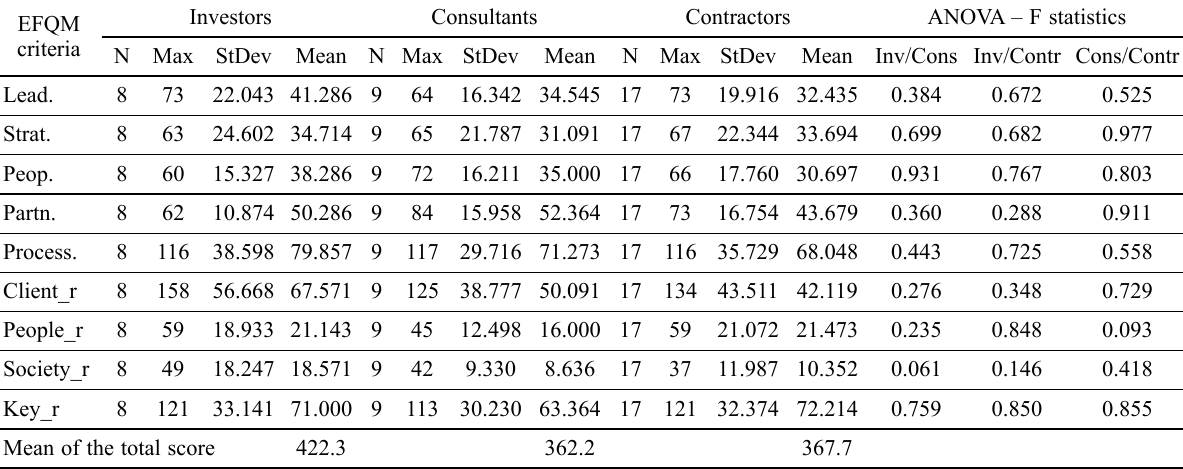
Table 1. Descriptives of the three perspectives and ANOVA to evaluate differences among the investors, consultants and contractors Investors Consultants Contractors ANOVA – F EFQM criteria